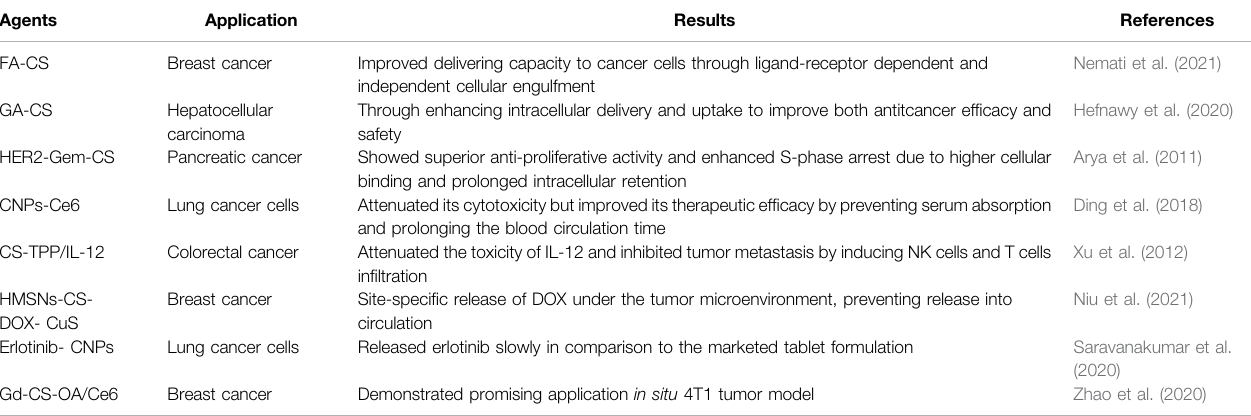
TABLE 3 | A few examples of chitosan based other therapeutic agents nanoparticles and their application in oncotherapies over the last decades.